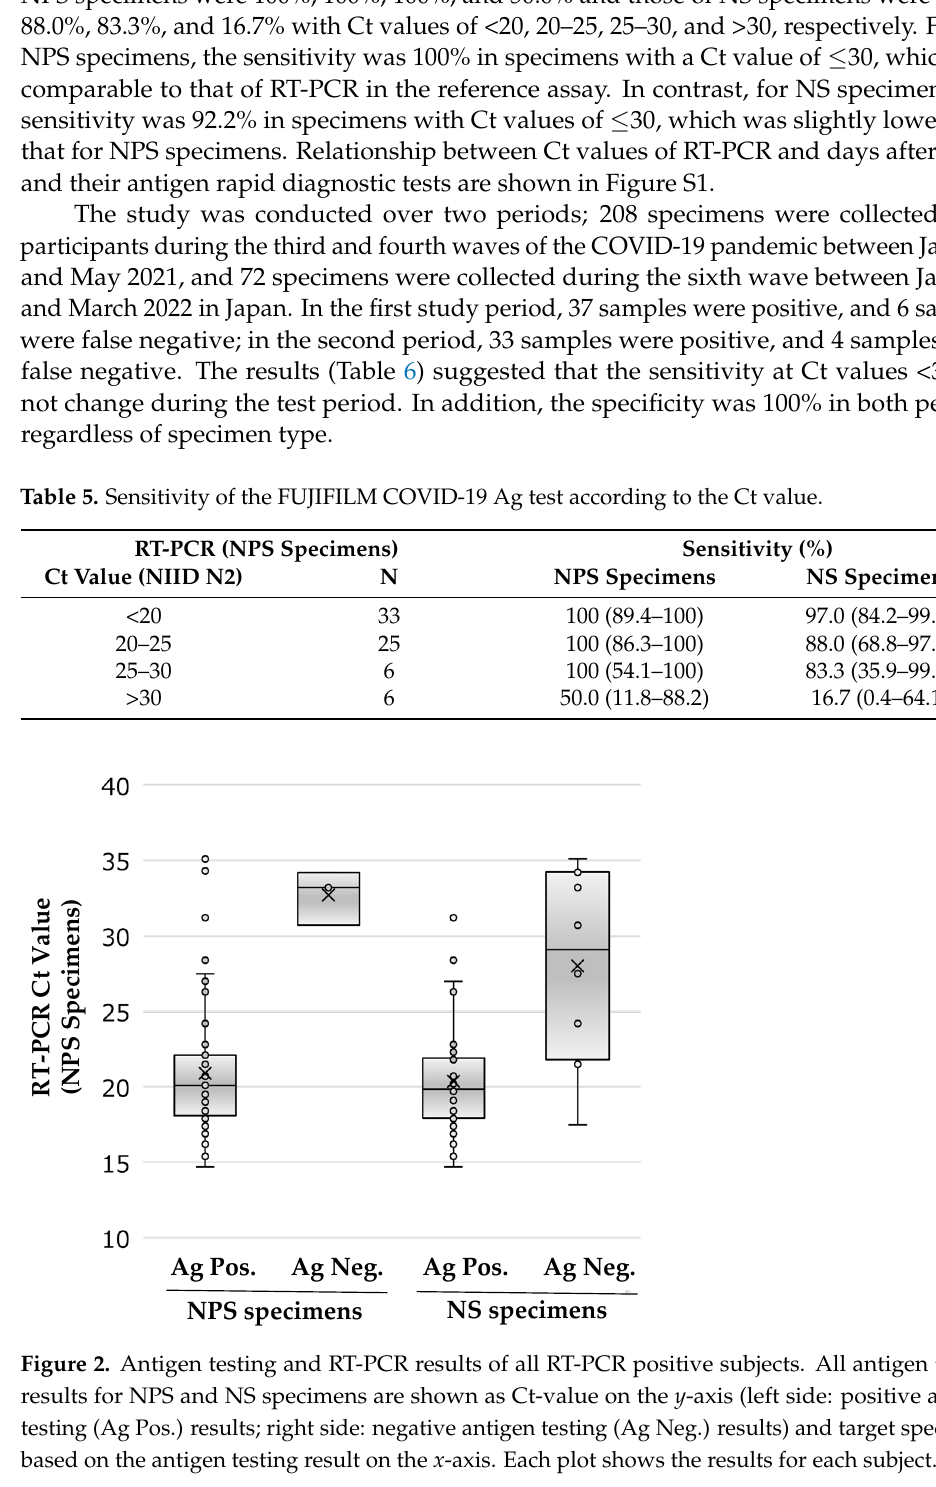
Table 5. Sensitivity of the FUJIFILM COVID-19 Ag test according to the Ct value.